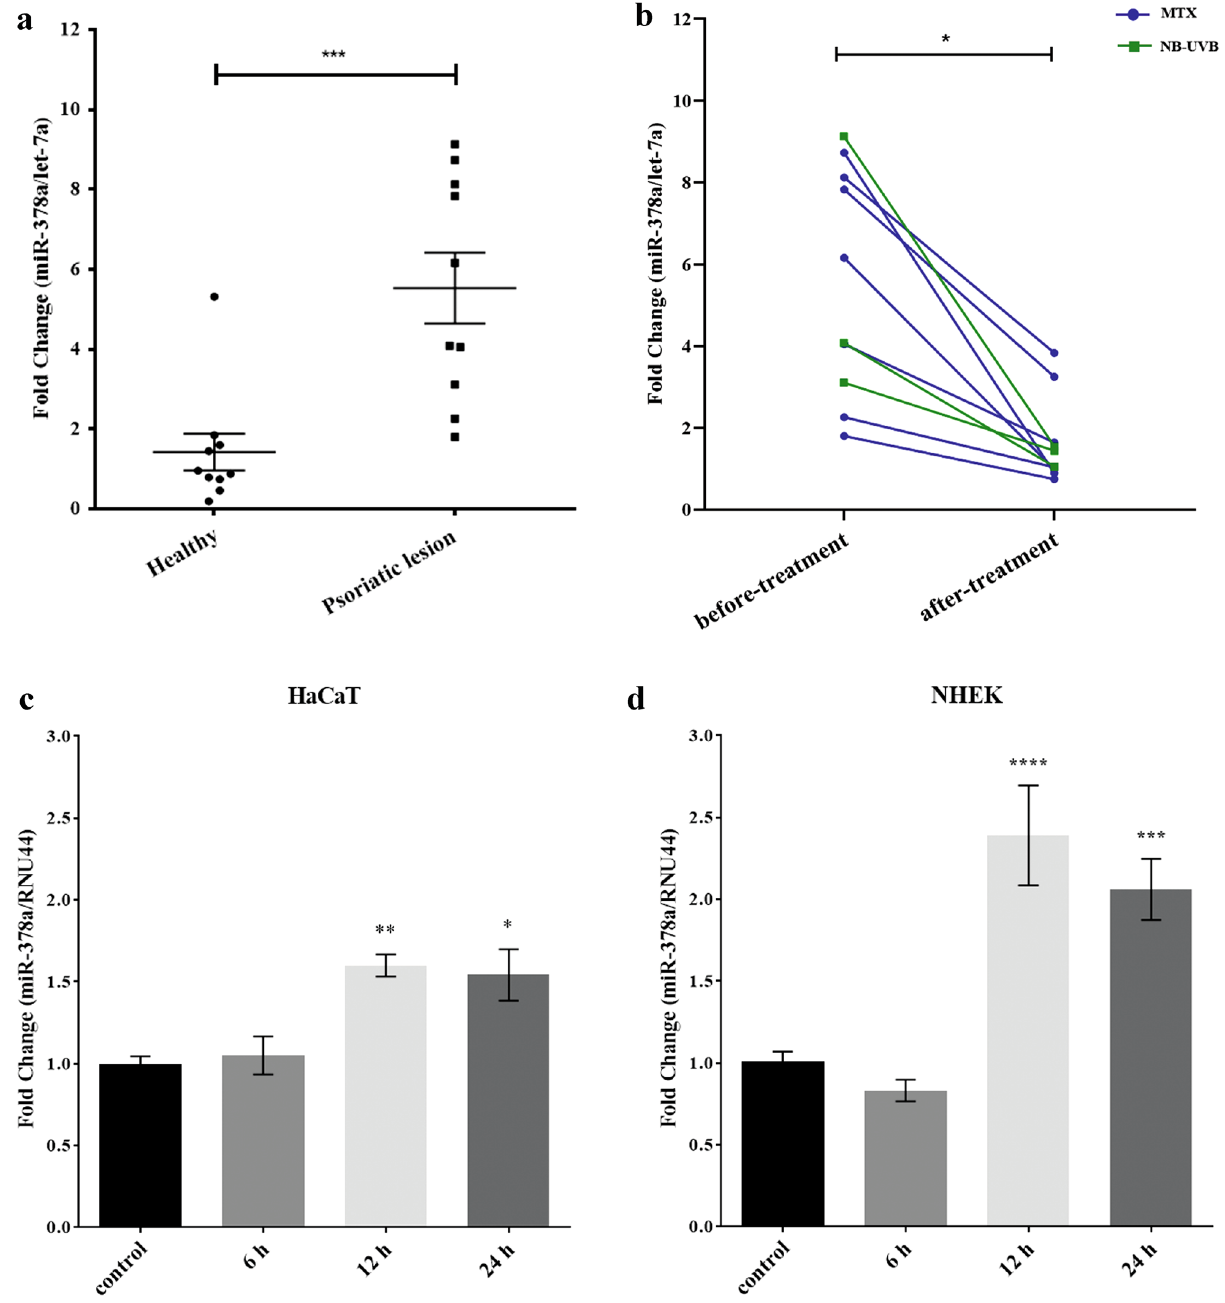
Figure 1. The expression level of miR-378a was elevated in active psoriasis. ( a ) The expression level of miR-378s in psoriatic lesions from Thai patients (n = 10) compared with healthy individuals (n = 10) was analyzed using an unpaired t-test . ( b ) The expression level of miR-378a in paired psoriatic skin lesions before and after treatment with MTX (blue; n = 7) and paired psoriatic skin lesions before and after treatment with NB-UVB (green; n = 3) were analyzed using a paired t-test . Expression levels of micro RNA were normalized with let-7a expression from the skin biopsies. The expression level of miR-378a in ( c ) immortalized human keratinocytes HaCaT cells, and ( d ) normal human keratinocytes (NHEK) both stimulated with synergistic cytokines (TNF-α + IL-17A) for 6, 12, 24, and 48 h. Expression levels of miRNA were normalized with RNU44 expression from HaCaT cells. Error bars indicate mean ± SEM, ***indicates P < 0.001, **indicates P < 0.01, and *indicates P <